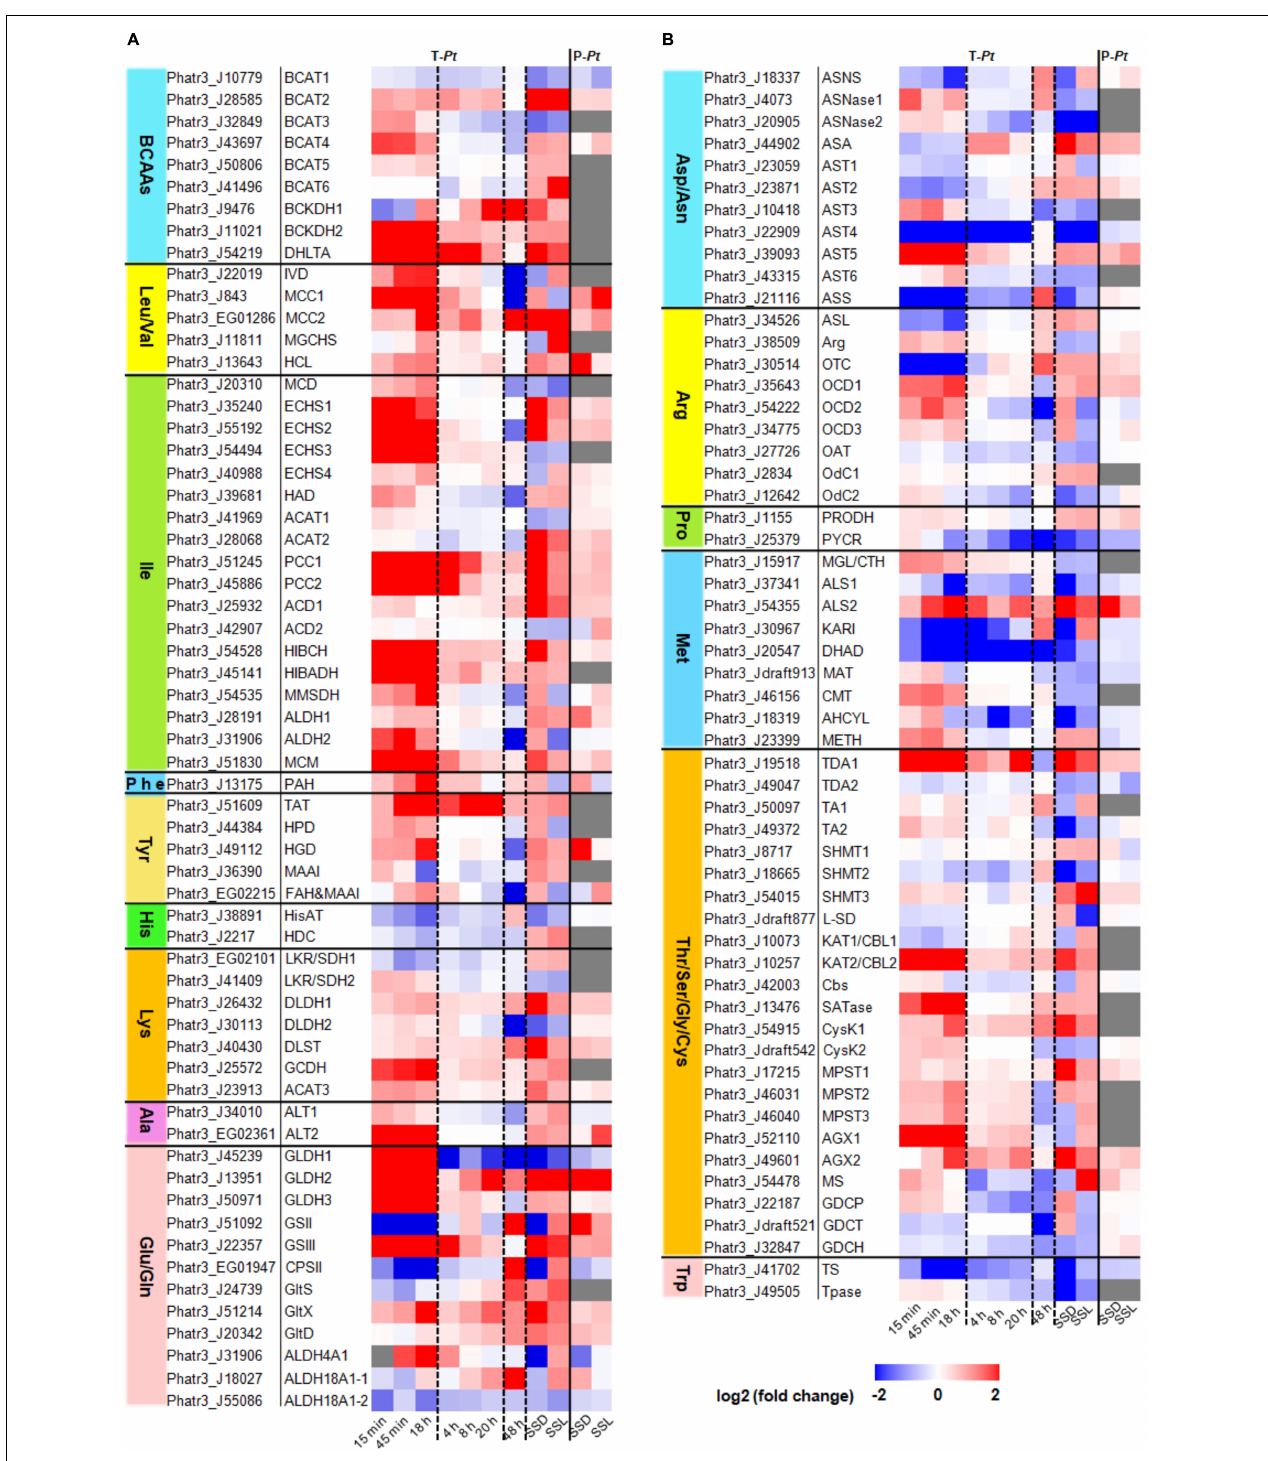
FIGURE 2 | Expression levels of amino acid catabolism-related genes in P. tricornutum . Transcriptome data of 15 min, 45 min, and 18 h were cited from Smith et al. (2019). Fold changes of 15 min, 45 min, and 18 h were re-calculated by N-4, N-5, and N-6 contrasting with pre_3, respectively. Transcriptome data of 4, 8, and 20 h were cited from Matthijs et al. (2016, 2017). Transcriptome data of 48 h were cited from Levitan et al. (2015). The transcriptome data and the proteome data of SSL (nitrogen stress to steady state in the light period) and SSD (nitrogen stress to steady state in the dark period) were cited from Remmers et al. (2018). T- Pt , transcriptome of P. tricornutum ; P- Pt , proteome of P. tricornutum . The homologous genes in T. pseudonana and the fold changes and RPKM data were shown in Supplementary Tables 1, 2 , respectively. All the experimental conditions were shown in the Supplementary Material . The abbreviations of related enzymes are the same as those in Figure 1